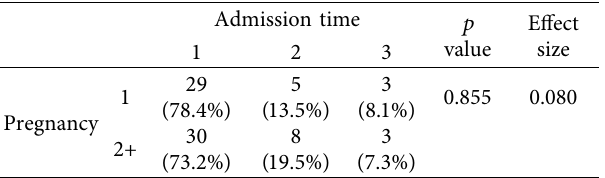
Table 2: Relationship between number of pregnancies and ad- mission